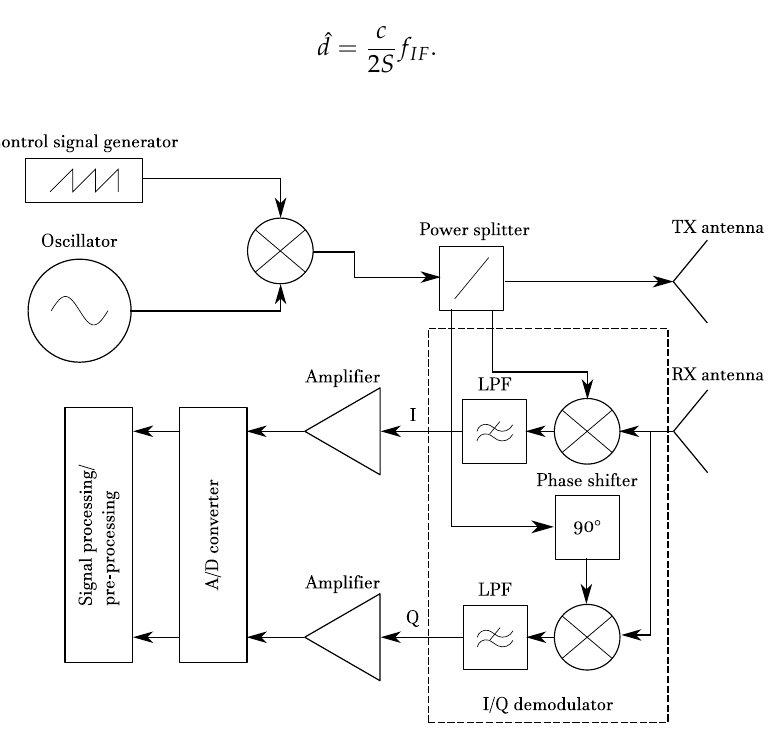
Figure 5. FMCW radar